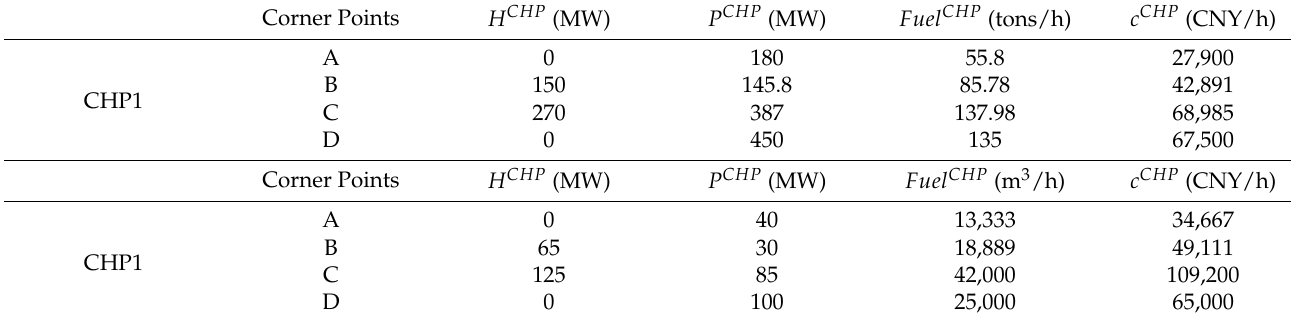
Table A3. CHP operation parameter.